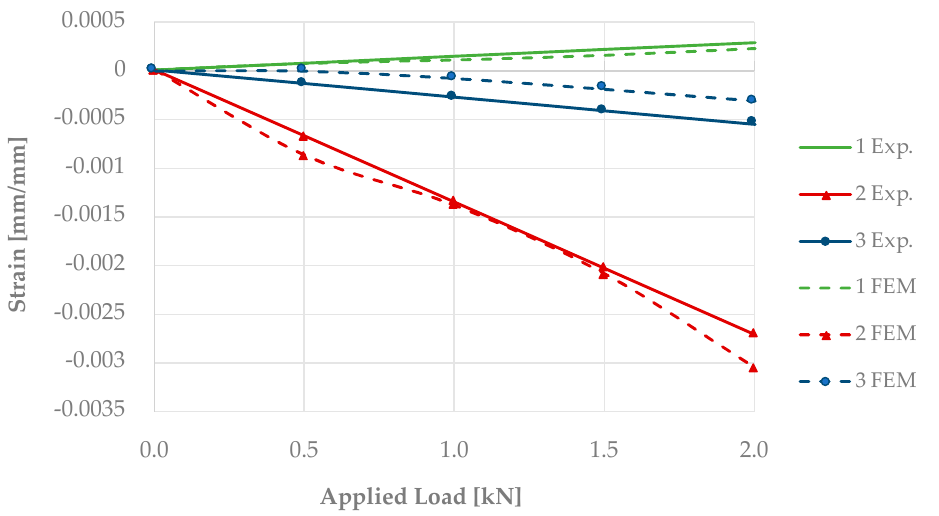
Figure 18. Strain results (Exp.—refers to experimental results. FEM—refers to finite element method results).